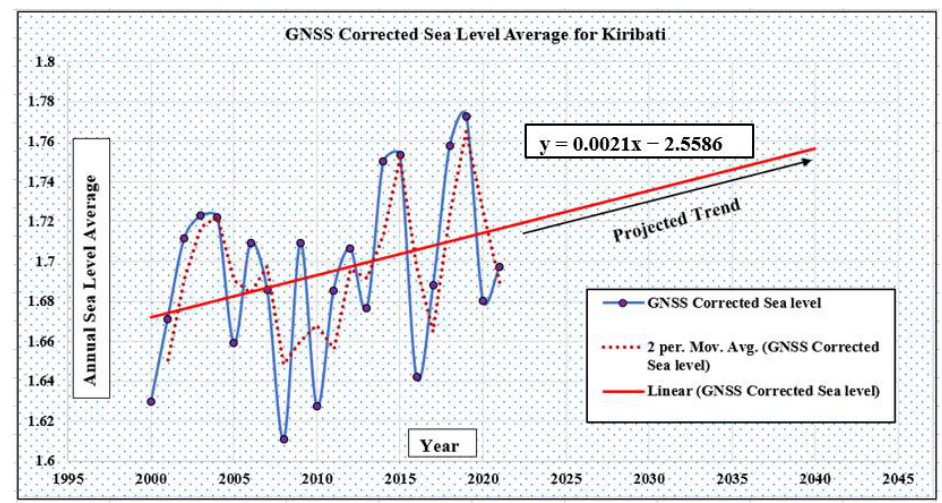
Figure 18. Annual GNSS VLM-corrected sea level average from 2001 to 2021 with 2 per moving average and linear projection to the year 2040 for Kiribati.